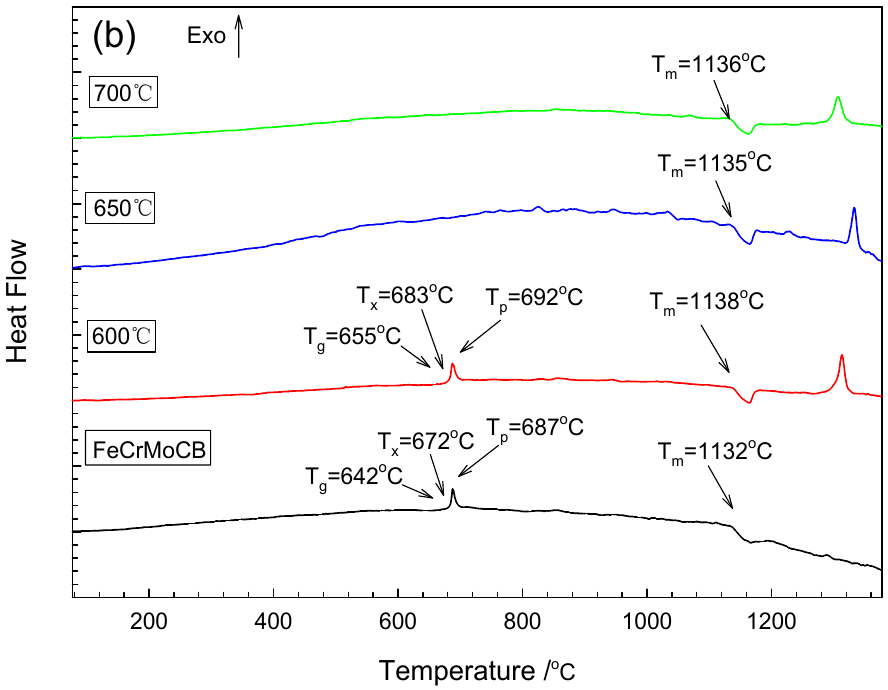
Materials 2021 , 14 , x FOR PEER REVIEW